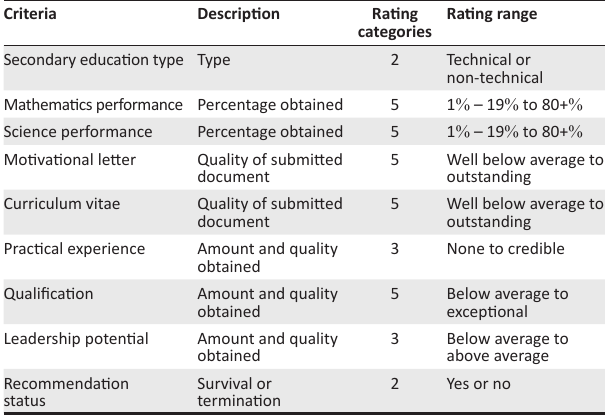
TABLE 2: Operationalisation of phase two